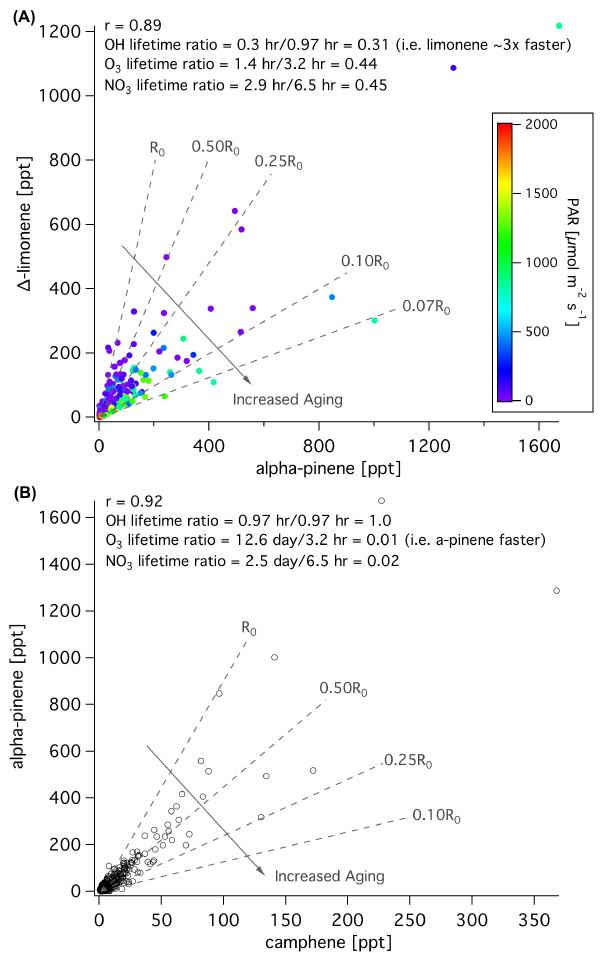
Figure 7: Observations of monoterpene pairs at the Bakersfield site. (A) Δ -limonene vs. α - pinene. Ratios of lifetimes to all three atmospheric oxidants show faster processing of Δ - Figure 7. Observations of monoterpene pairs at the Bakersfield site. limonene. Given the concentrations of radicals, OH oxidation has the fastest timescales and the (A) 1 -limonene vs. α -pinene. Ratios of lifetimes to all three atmo- importance of OH oxidation is also indicated by the most aged parcels coinciding with PAR spheric oxidants show faster processing of 1 -limonene. Given the (representative of OH production). (B) A comparison of α -pinene vs. camphene at Bakersfield concentrations of radicals, OH oxidation has the fastest timescales shows evidence of aging by O 3 and NO 3 as α -pinene and camphene’s lifetimes to OH are and the importance of OH oxidation is also indicated by the most identical. aged parcels coinciding with PAR (representative of OH produc- tion). (B) A comparison of α -pinene vs. camphene at Bakersfield shows evidence of aging by O 3 and NO 3 as α -pinene and cam- phene’s lifetimes to OH are identical.